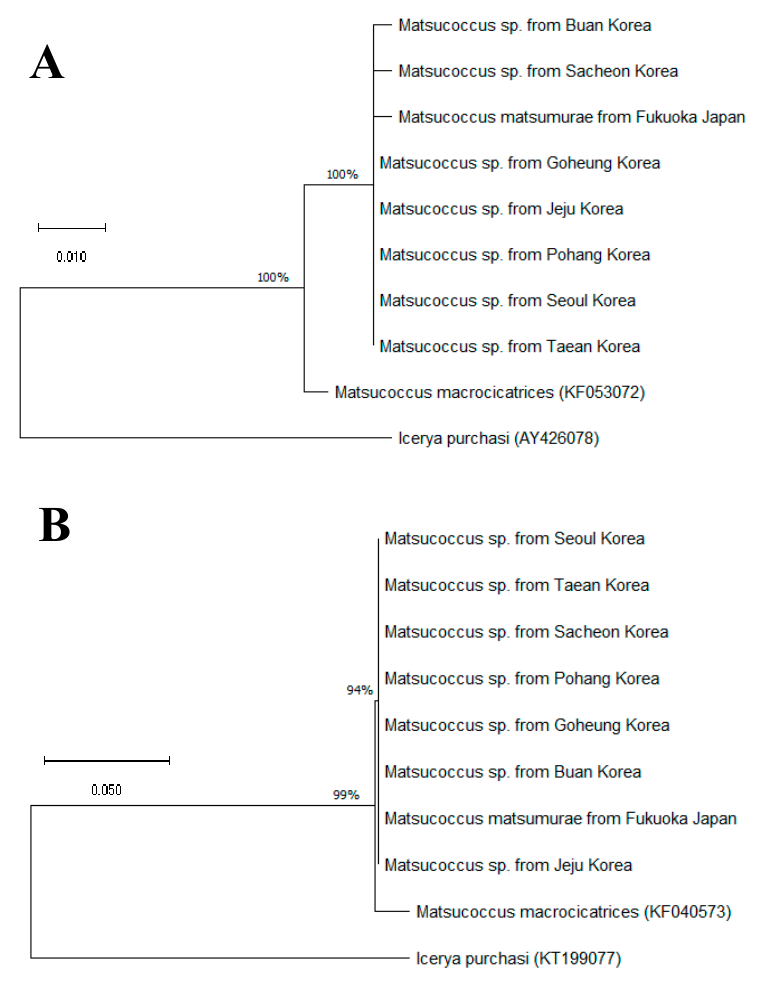
Figure 7. Neighbor-joining (NJ) tree analyses (using Kimura 2-parameter model) of seven regional populations of Matsucoccus sp. from Korea and M. matsumurae from Japan. A . 18S; B . 28S.